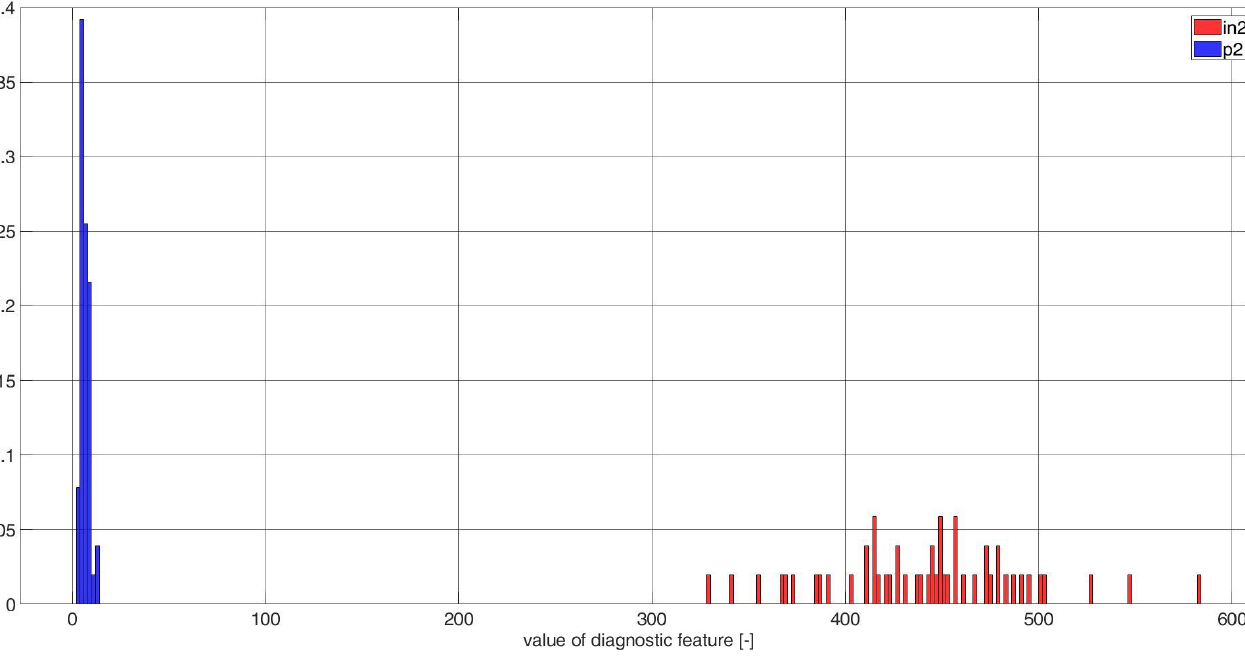
Figure A20. Histograms of diagnostic features based on the CCSM3 (correlation number is 21 — Table A1) bearings in2 and p2.